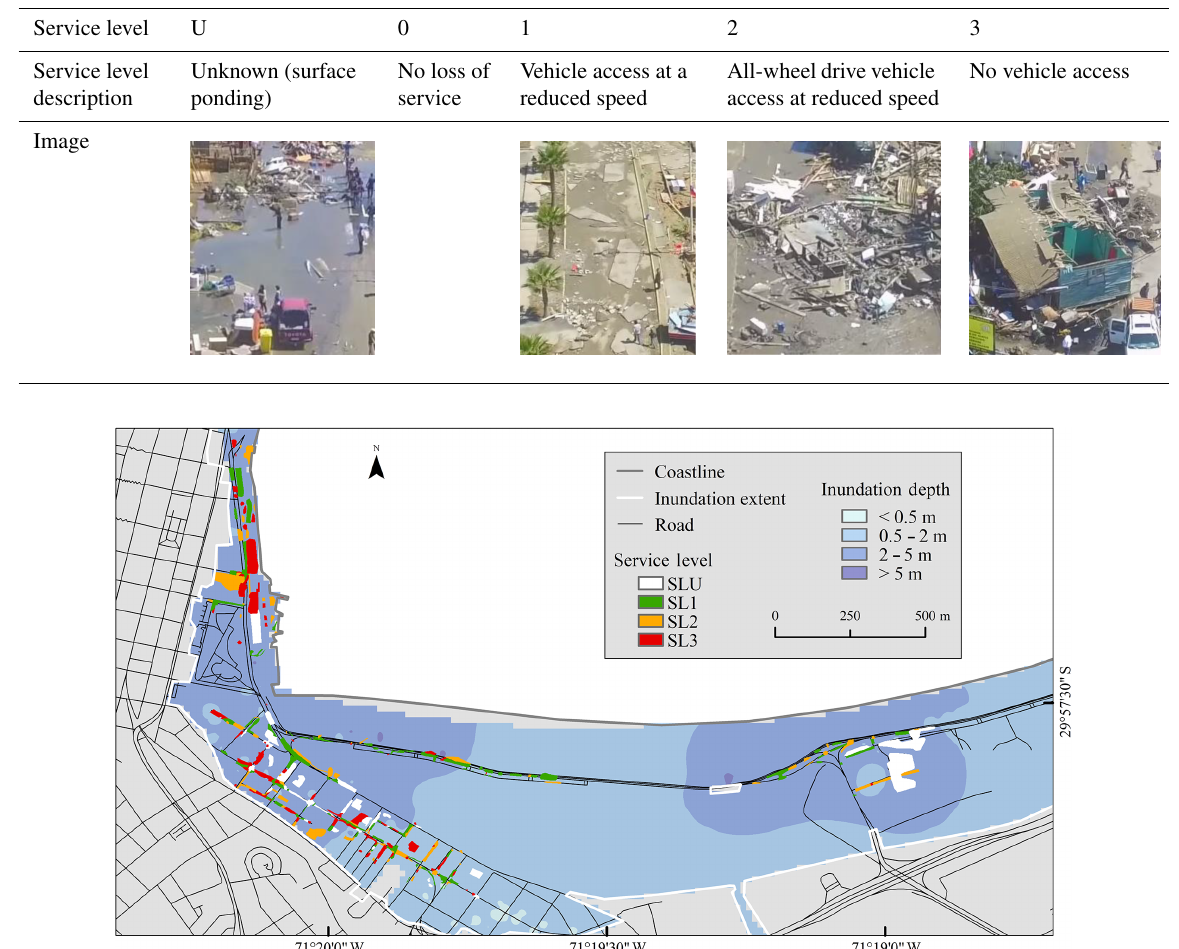
Figure 9. Service levels associated with debris on roads in Coquimbo following the 2015 Illapel earthquake and tsunami, Chile. © Open- StreetMap contributors 2015. Distributed under a Creative Commons BY-SA